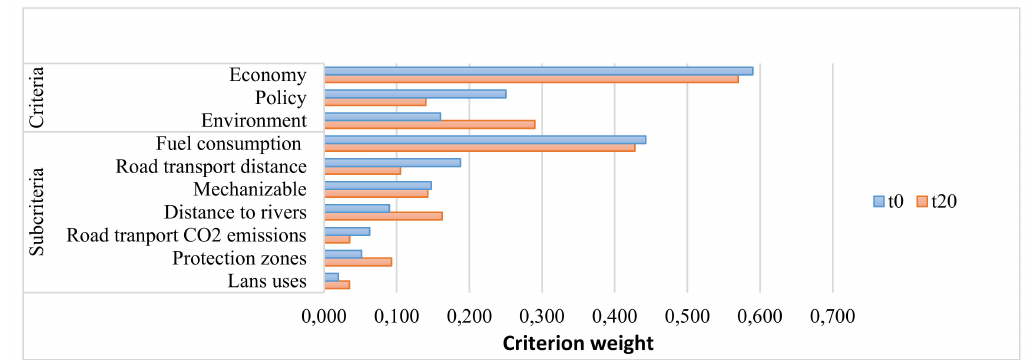
Figure 6. Ranking of weights for criteria and sub-criteria for t 0 (blue bars) used in the generic value model and trends over a period of 20 years (t 20 , orange bars) in the Nordeste region,